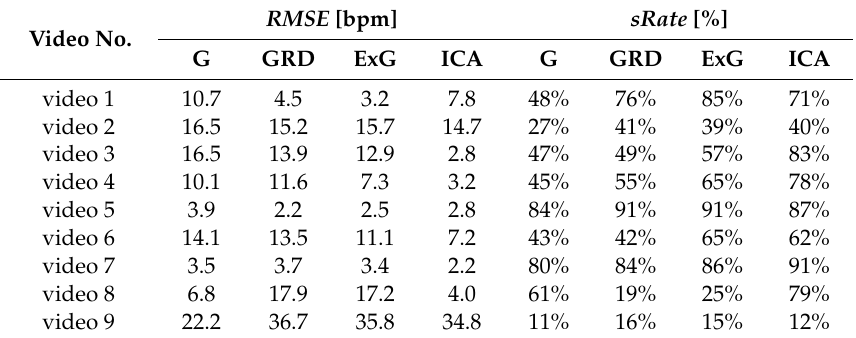
Table A4. Results of HR estimation, algorithm No. 2 (AR)—comparison of signal extraction methods. Video No.